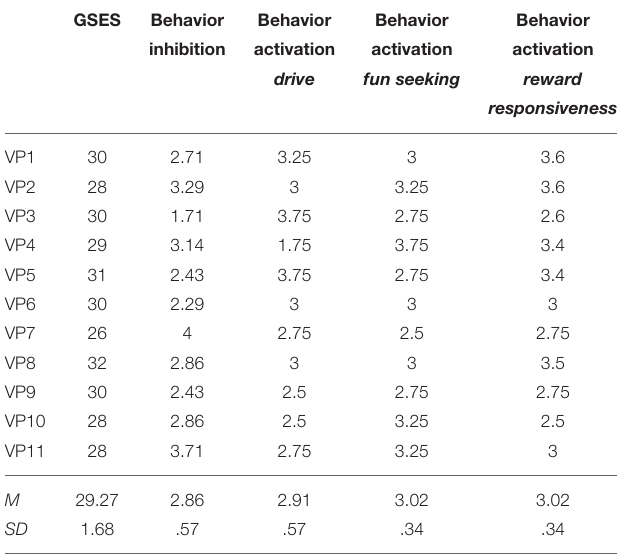
TABLE 4 | Test values for the GSES and the BIS/BAS